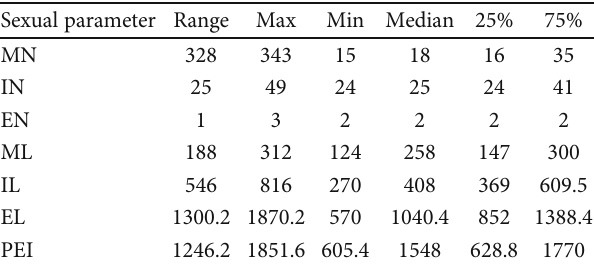
Table 1: Sexual behavioral parameters in the social cohabitation with mating group, where subjects could mate freely. The data was collected during the fi rst 2 h ( n = 7